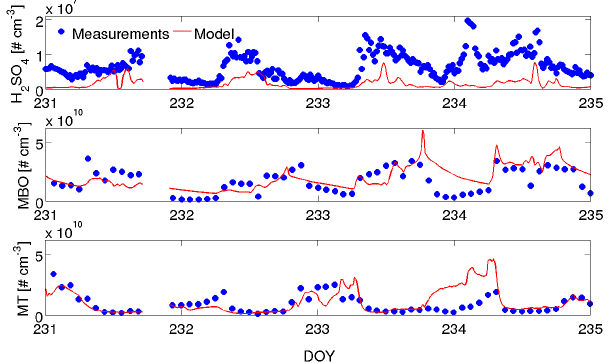
Figure 11. Modeled and measured H 2 SO 4 (top), MBO (middle) and monoterpene (MT, bottom) concentrations from 19 August 2010 (DOY 231) to 22 August 2010 (DOY 234). Data were re- moved for late afternoon–early evening of day 231 to exclude in- fluence from precipitation for 2h after precipitation ended. Mea- surements are shown as blue circles, and the model simulations are indicated by the red line. Comparisons for sulfuric acid are made at 2m; comparisons for MBO and MT are made at